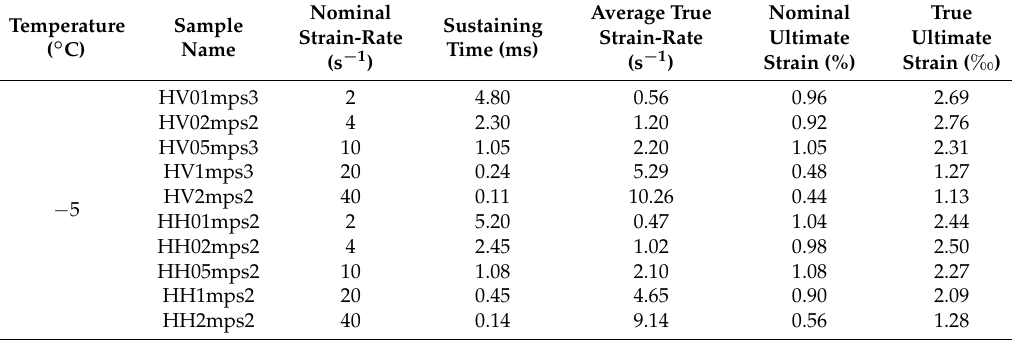
Figure 13. Average true strain-rate versus image NO profiles of sample HH05mps2 at − 10 °C: ( a ) y -direction true strain-rate; and ( b ) x -direction true strain-rate. Table 2. Ultimate strain and strain-rate results of hard ice derived from actuator displacement and DSCM. HH denotes the hard ice sample loaded in the horizontal direction; HV denotes the hard ice sample loaded in the vertical direction.